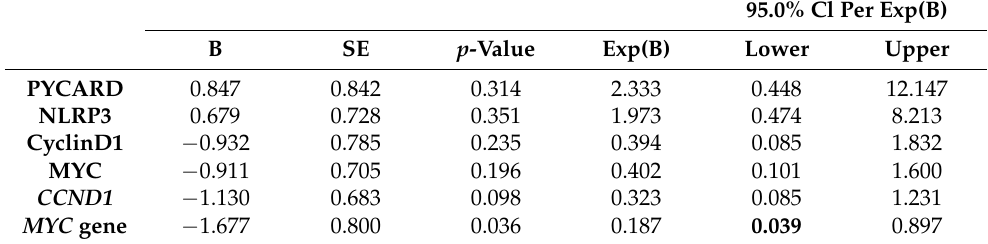
Table 6. Multivariate analysis of